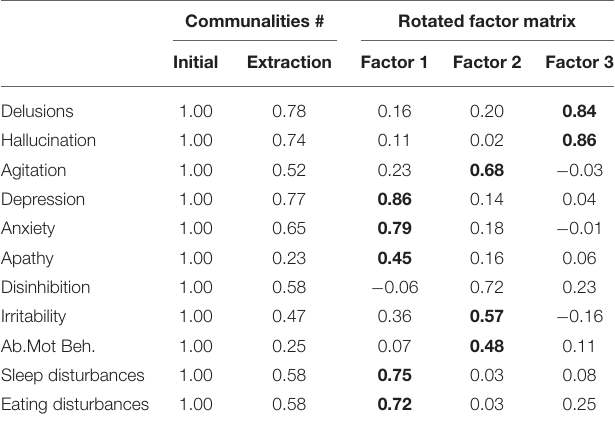
TABLE 2 | Communalities and rotated factor matrix across all subjects.